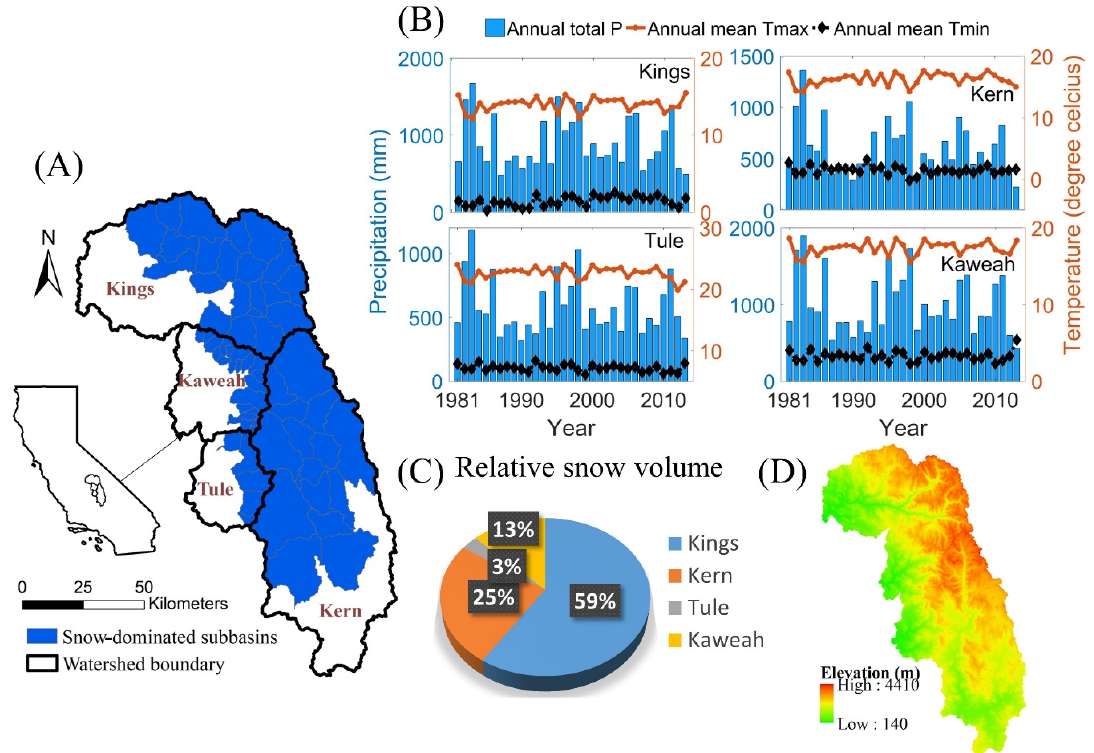
Figure 1. Locations of four upland watersheds (Kings, Kern, Tule, and Kaweah) and their historical climates. ( A ) The layout map of four watersheds and snow-dominated sub-watersheds. ( B ) The annual total precipitation, annual mean maximum temperature, and annual mean minimum temperature for each watershed. ( C ) The percentage of snow (volume) to the sum of the total snow from four upland watersheds based on the Parallel Balance Model (ParBal) snow water-equivalent (SWE) reconstruction data during 2001–2007 (snow calibration period defined in the S3 scenario). ( D ) The digital elevation model of the study area.